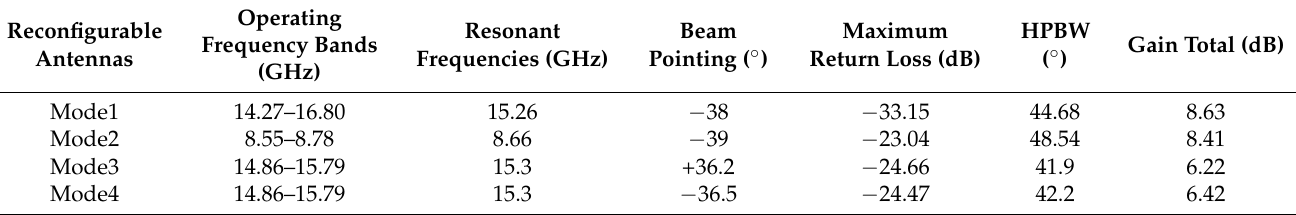
Table 2. Design results of frequency and pattern reconfigurable